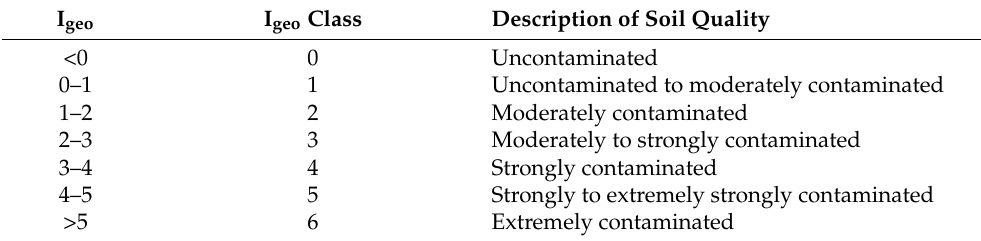
Table 3. Classification of the geoaccumulation